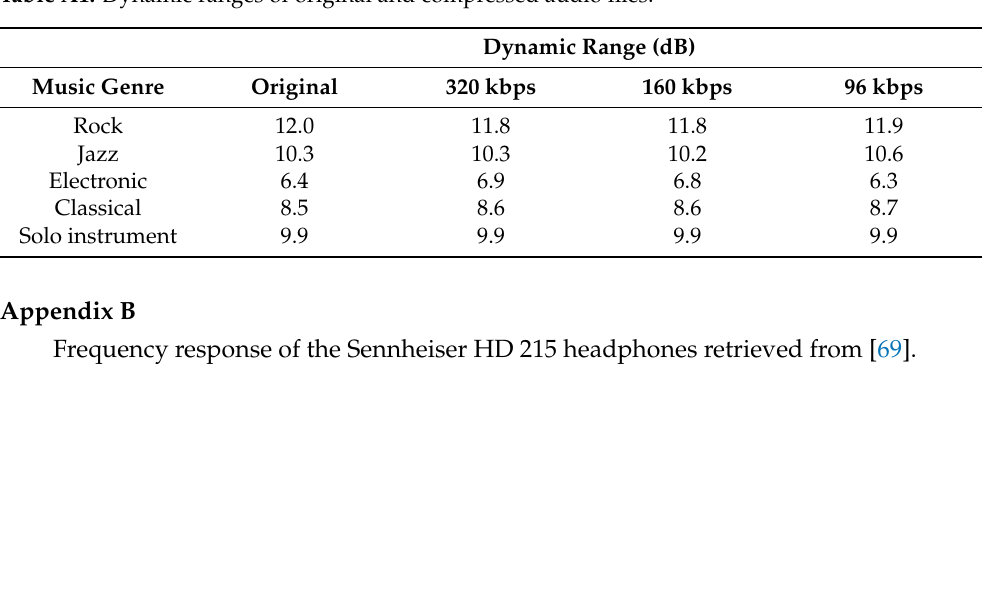
Table A1. Dynamic ranges of original and compressed audio